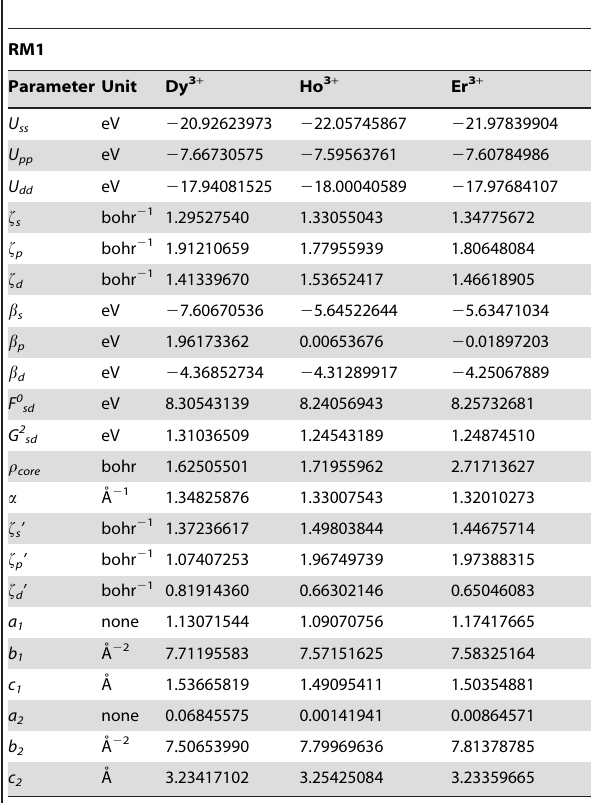
Table 1. Parameters* for the RM1 model for the trications of Dy, Ho and